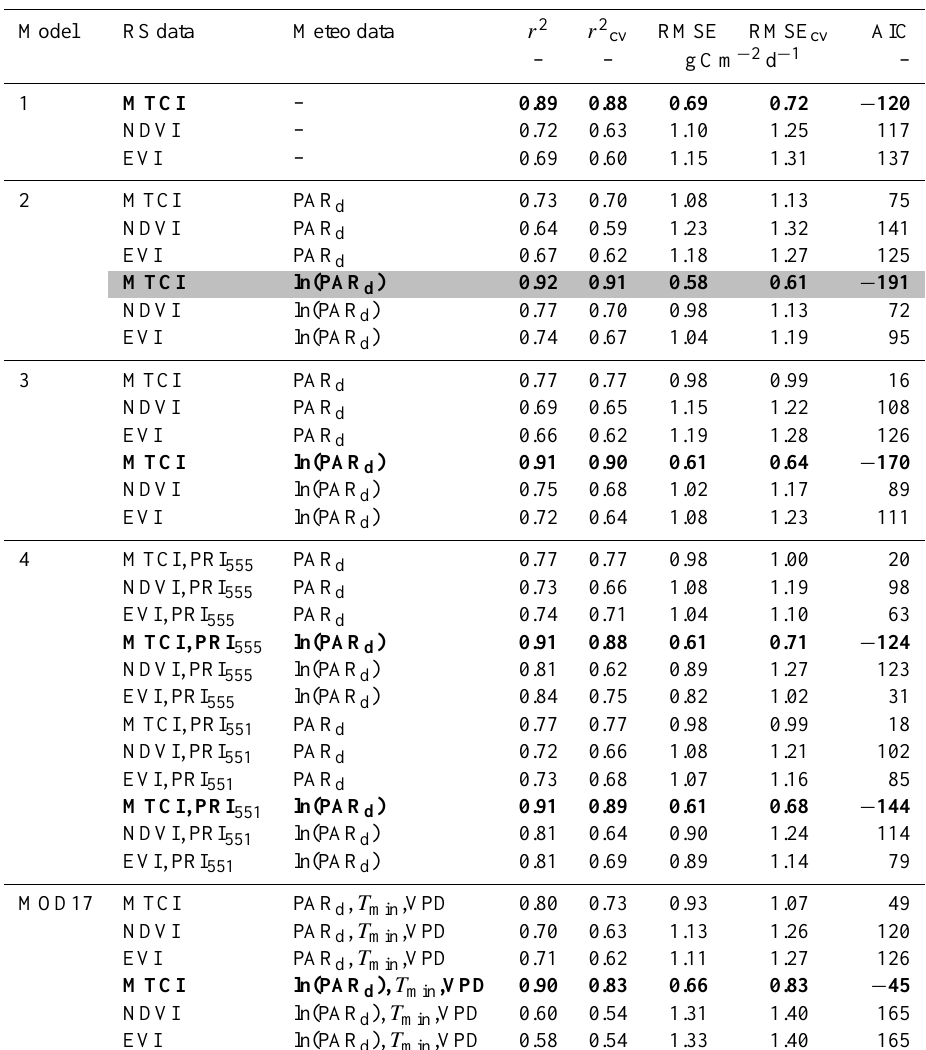
Table 6. Summary of statistics in fitting ( r 2 and RMSE) and cross-validation ( r 2 cv , RMSE cv and AIC) of different models tested in this study using GPP d and PAR d data and resampled VI time series. The best-performing models in each class are in bold print. The most successful of all models is grey